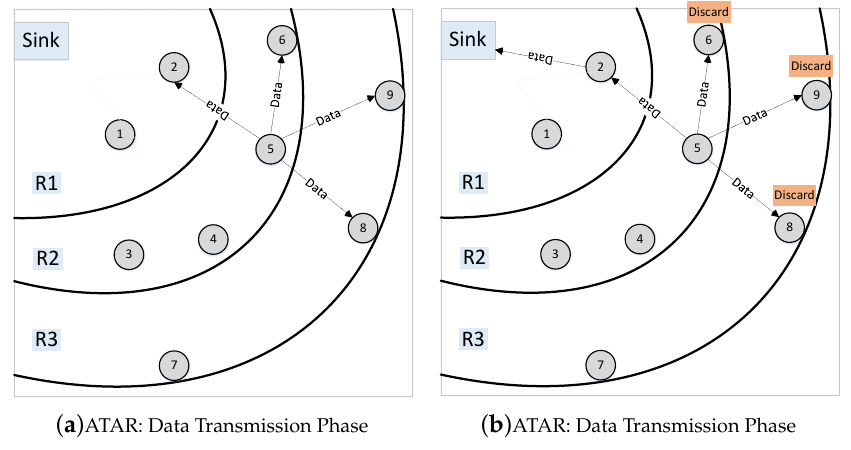
Figure 12. ATAR: Data Transmission